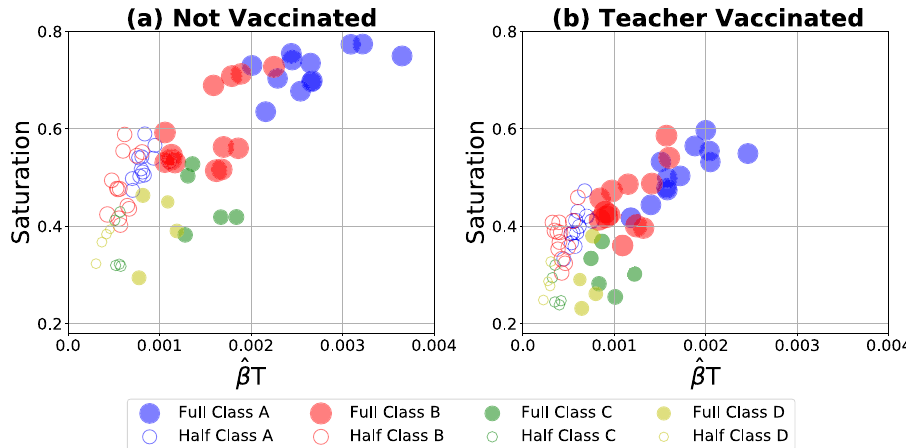
ˆ β T and saturation, where each of the 68 circles Figure 4. Scatter plot between the transmission likelihood represents a full-class or a half-class simulation of one of 34 observations in four classes for not vaccinated and teacher vaccinated scenarios (see Table 1). The area of each circle is proportional to the specific classroom density for a specific observation day, and the color represents Classes A–D for the full and half-sized simulations,